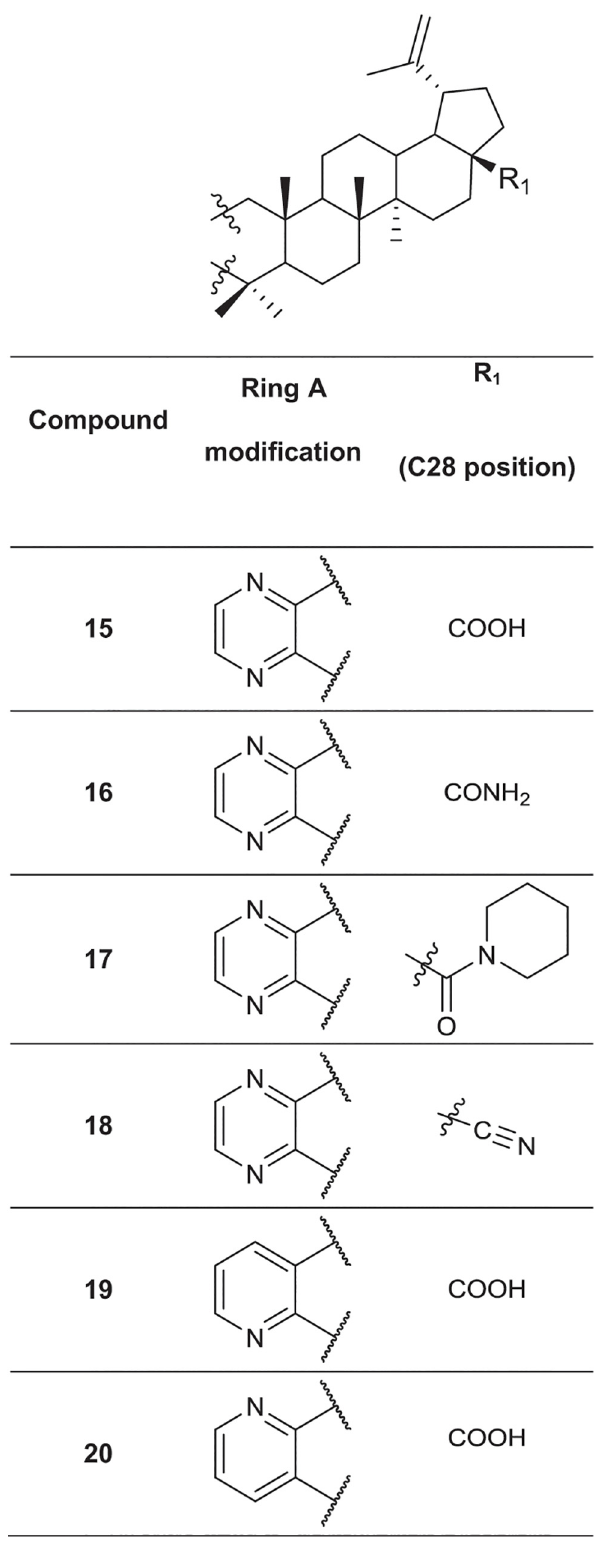
Fig 3. Chemical structures of the fused 6-membered ring derivatives of betulinic acid.